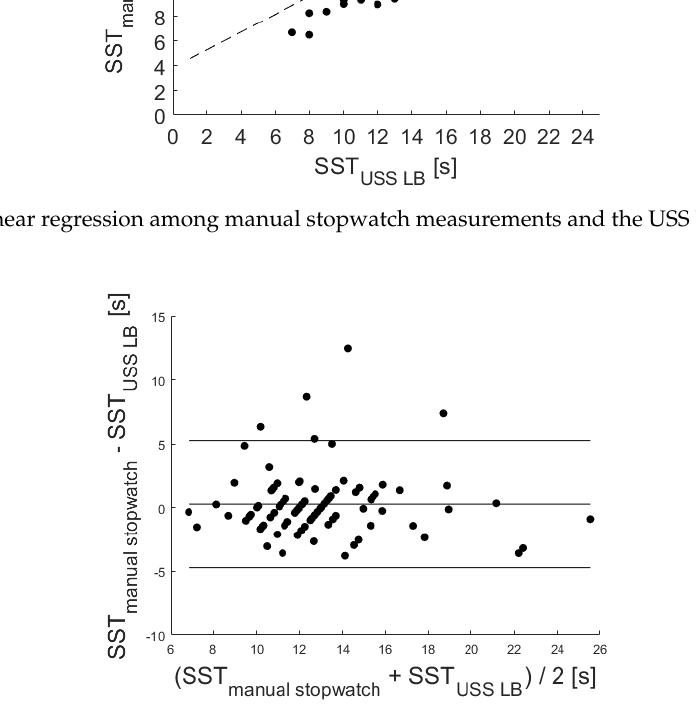
Figure 10. Corresponding Bland–Altman plot. Included levels indicate mean Diff ± 1.96 SD ( − 4.71 to 5.28